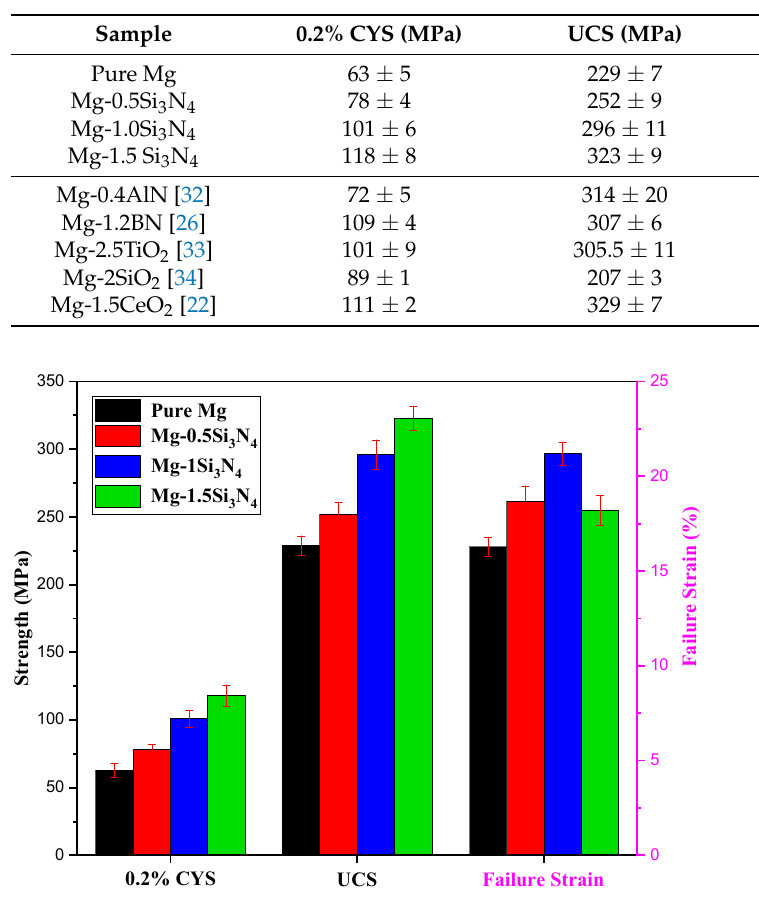
Figure 7. The effect of Si 3 N 4 nanoparticles on compression properties .